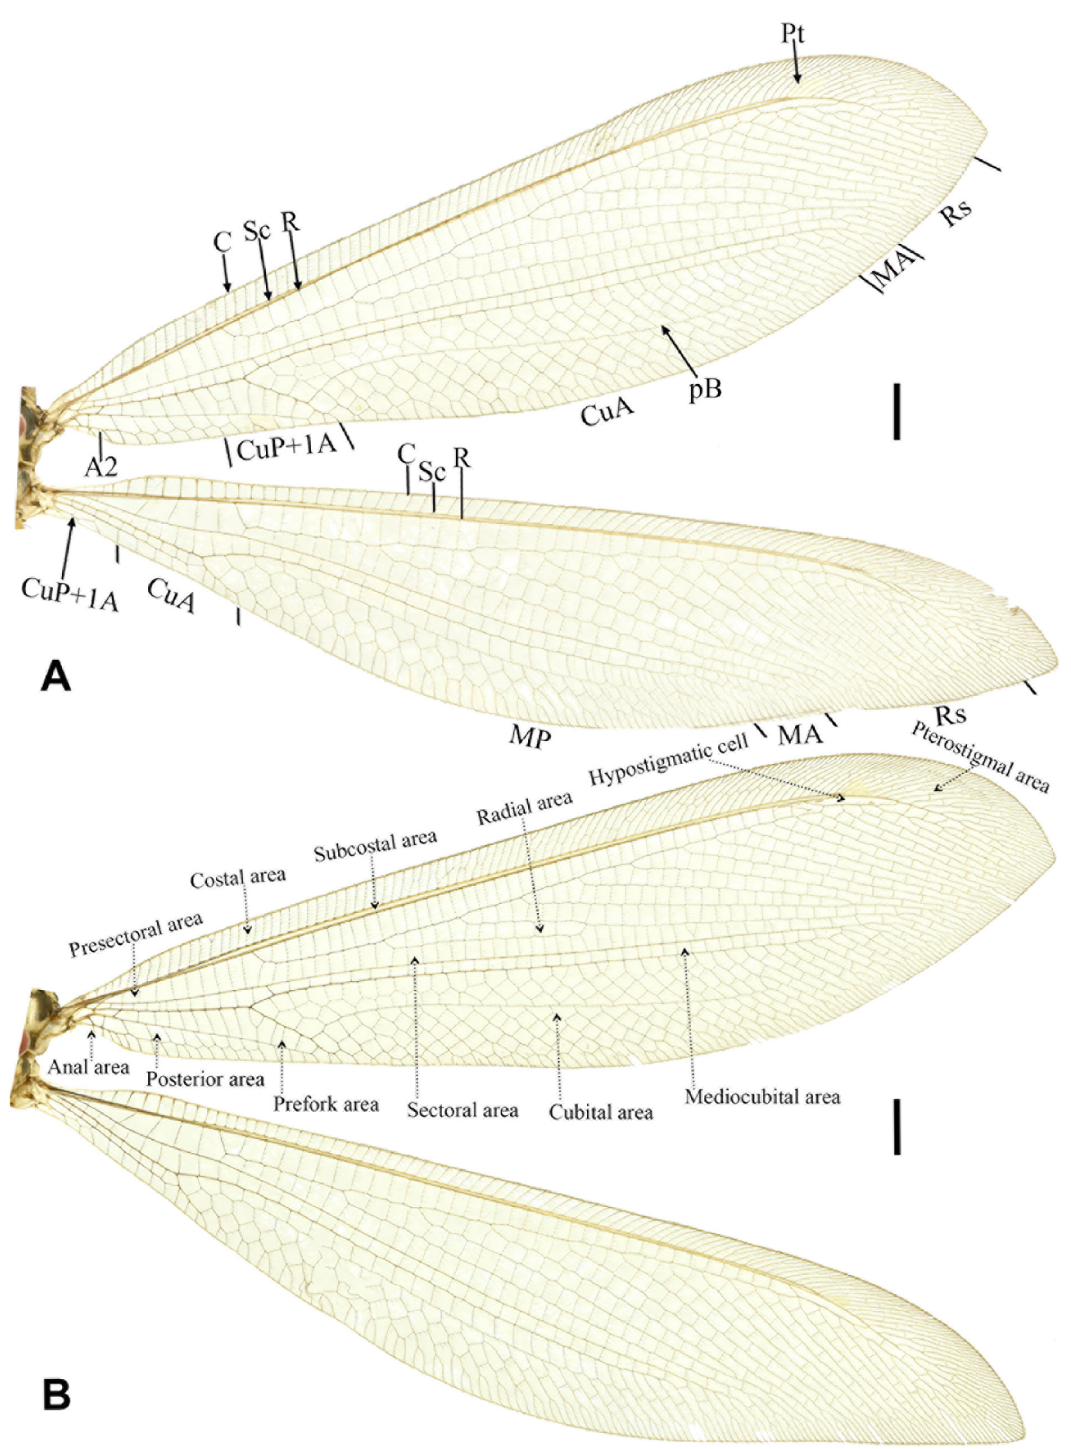
Fig. 2. Baliga kashmirensis sp. nov. Right fore- and hind wing. A . Male (CAUPK00001). B . Female (CAUPK00002). Abbreviations: A = anal vein; C = Costa; CuA = cubitus anterior; CuP = cubitus posterior; MA = media anterior; MP = media posterior; pB = posterior Banksian line; Pt = pterostigma; Sc = subcosta; R = radius.Scale bars = 2.0